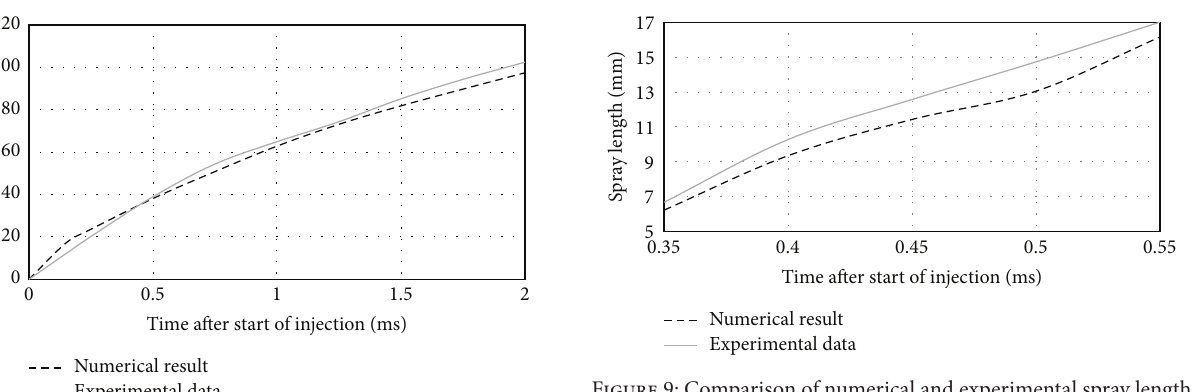
Figure 9: Comparison of numerical and experimental spray length of butanol at injection pressure of 720 bar [33].